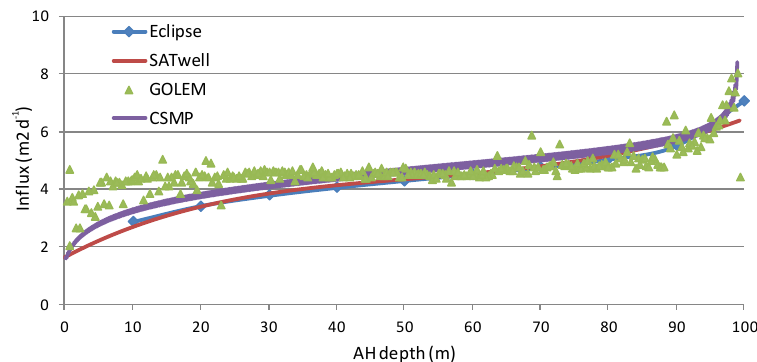
Figure 4. Comparison of the inflow profile for a horizontal radial (track 12 and 14 in Fig. 1) for case 2.